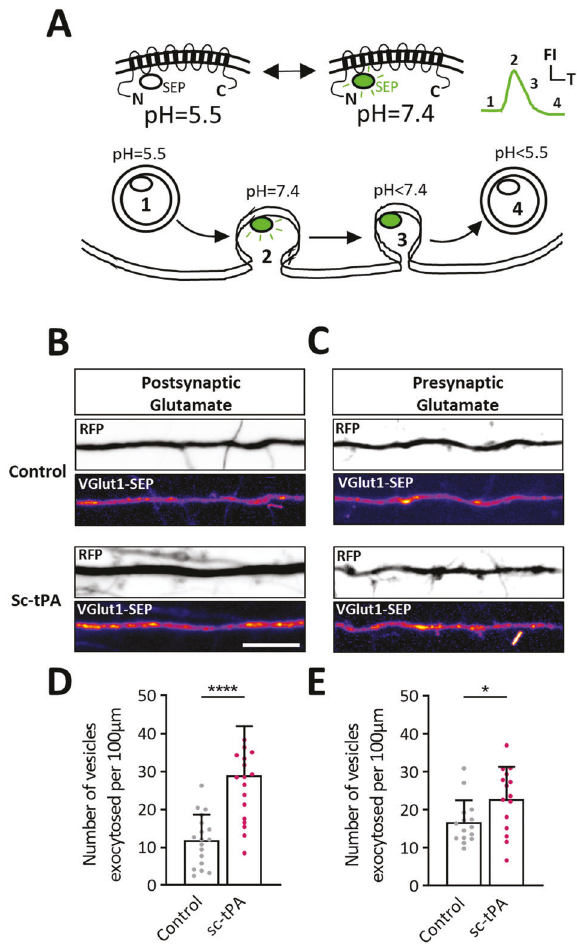
Fig. 6 tPA increases the pre and postsynaptic release of VGlut1 vesicles. A Schematic representation and function of VGlut1-SEP to vesicles. B , C Representative stacks of processes time lapse displaying a RFP (black and white) and Vglut1-SEP (pseudo-color) signal during control HBBSS or tPA (300 nM) treatment. D Quanti fi cations of the average number of VGlut1-SEP positives spots per 100 µm in dendrites in control HBBSS condition or after addition of exogenous tPA (300 nM). Control n = 18, tPA n = 19 dendrites from 10 to 12 neurons from 3 to 4 independent cultures. E Quanti fi cations of the average number of VGlut1-SEP positives spots per 100 µm in axons in control HBBSS condition or after addition of exogenous tPA (300 nM). Control n = 15, tPA n = 15 dendrites from 15 neurons